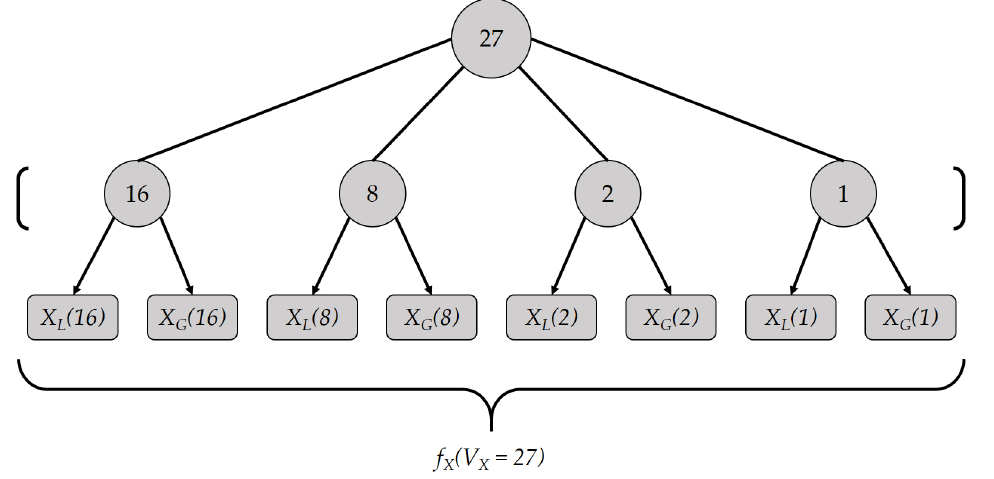
Figure 2. Encoding example: f X ( V X = 27 )